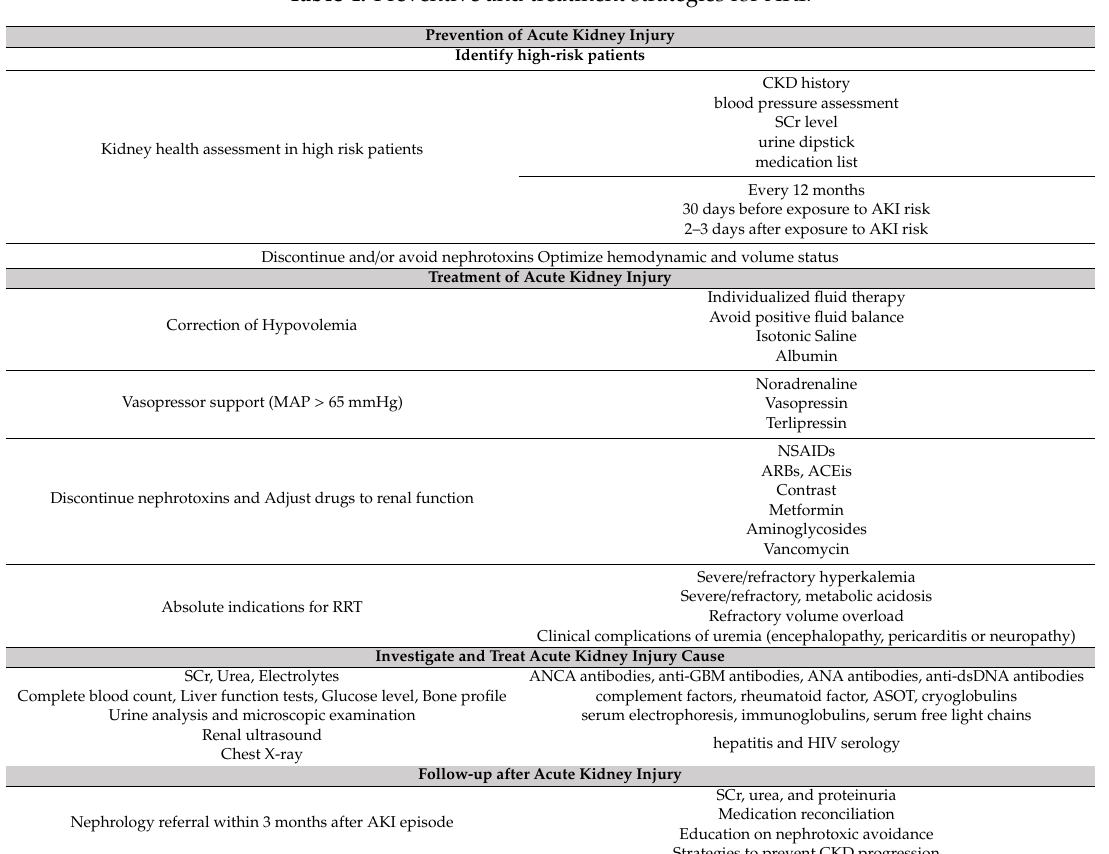
Table 4. Preventive and treatment strategies for